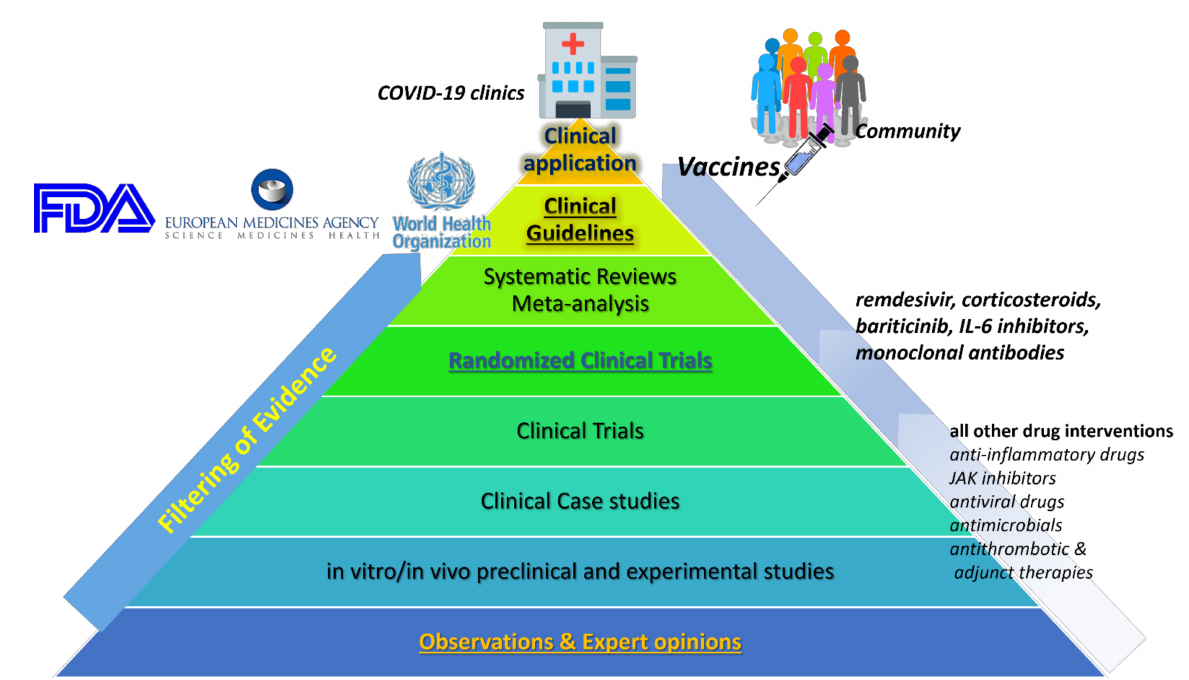
Figure 1. Classification of available medical options for COVID-19 emerged treatments based on available evidence